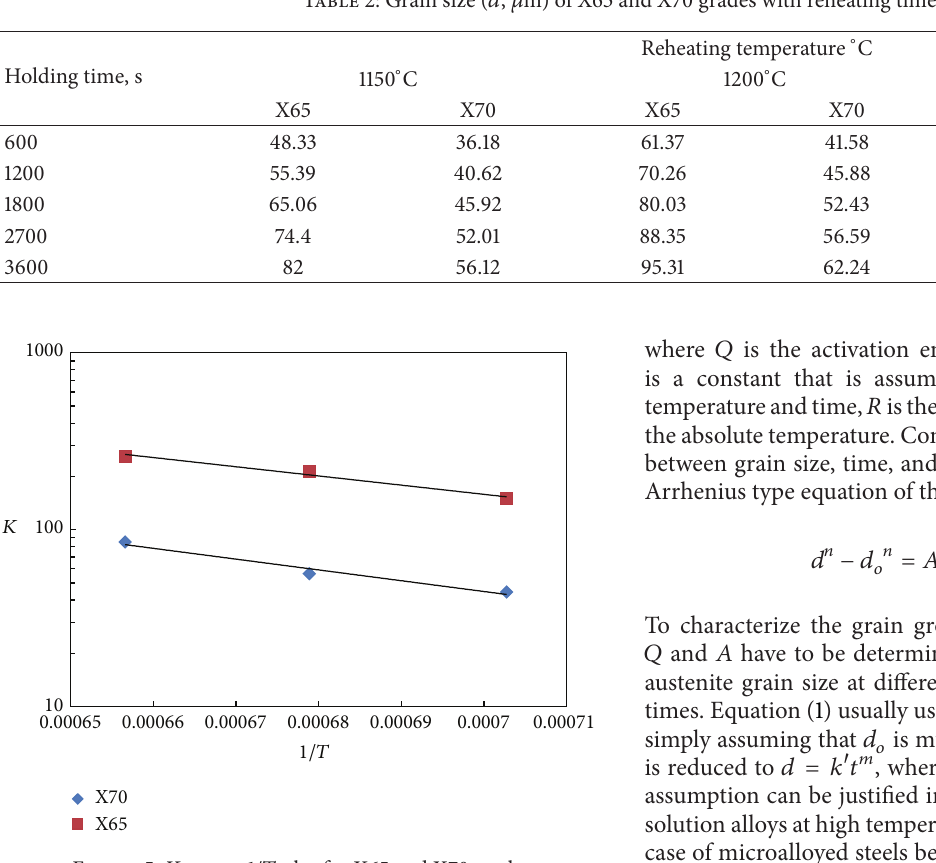
Figure 5: 𝐾 versus 1/ 𝑇 plot for X65 and X70